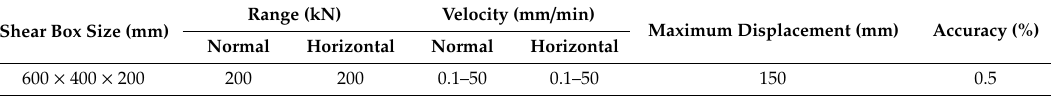
Table 1. Parameters of the SJW-200 direct shear apparatus